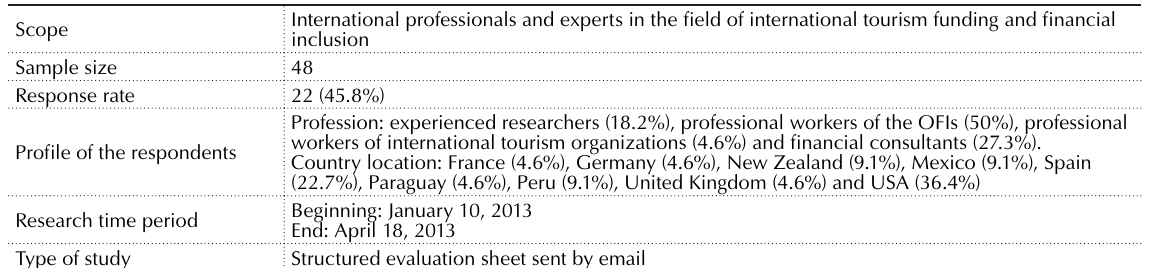
Table 1. Survey fact sheet